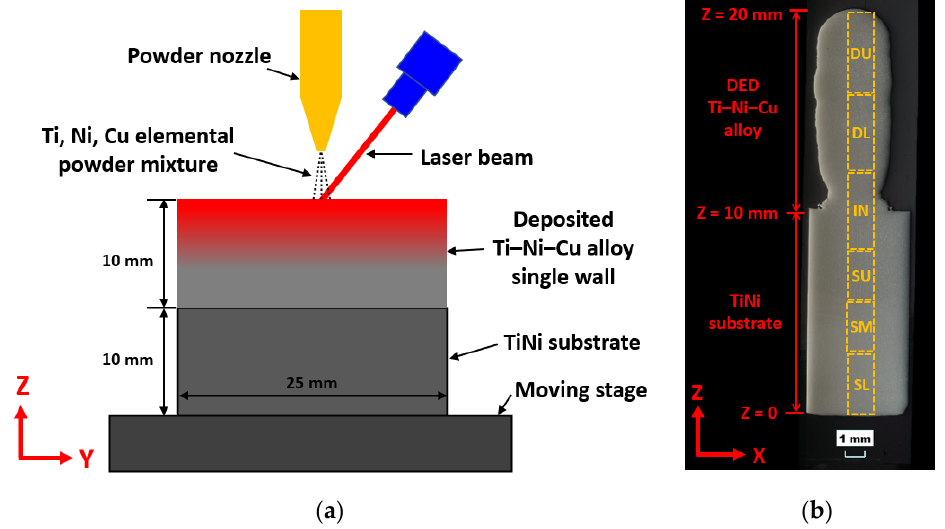
Figure 1. ( a ) The schematic of joining bi-metallic SMA using DED in this work. ( b ) Image of the XZ- plane cross-section of the bi-metallic structure including the TiNi substrate and the DED Ti–Ni–Cu alloy. The bottom line of the substrate has been marked as Z = 0. The Z height of the interface and the top point are 10 mm and 20 mm, respectively.